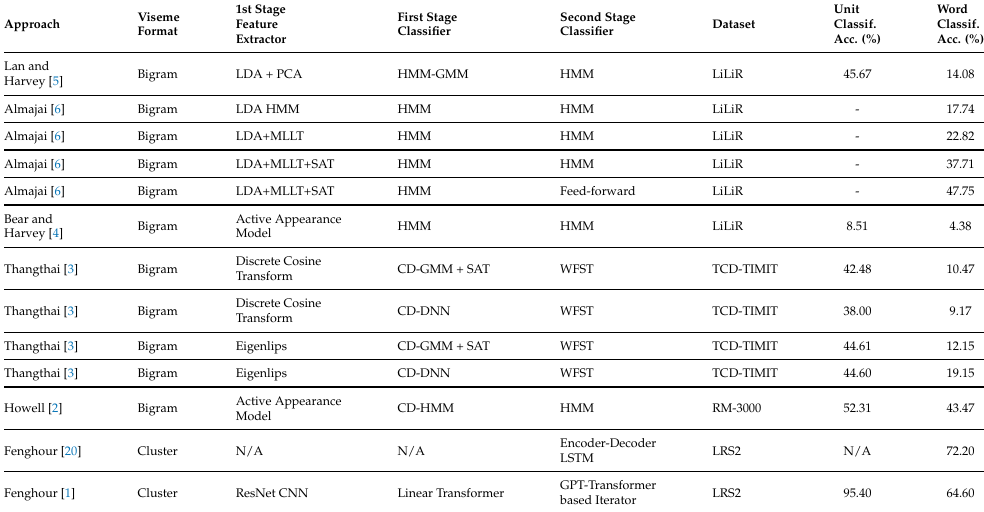
Table 1. Two-stage speech recognition approaches where CI and CD refer to context-independent and context-dependent models, and SAT referss to speaker adaptive